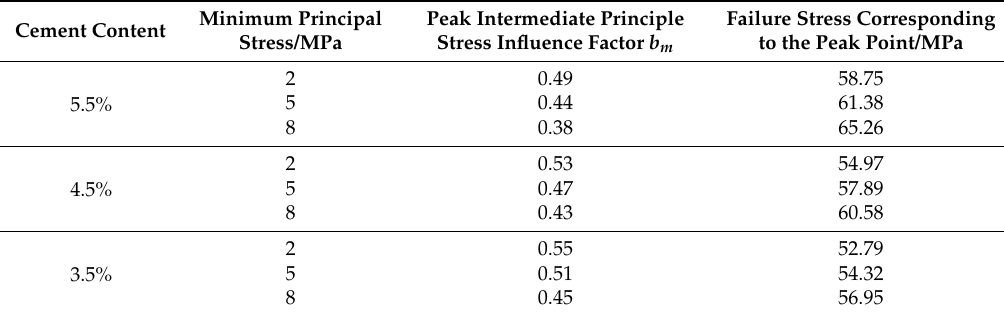
Table 4. Intermediate principal stress on the compressive strength of cement stabilized